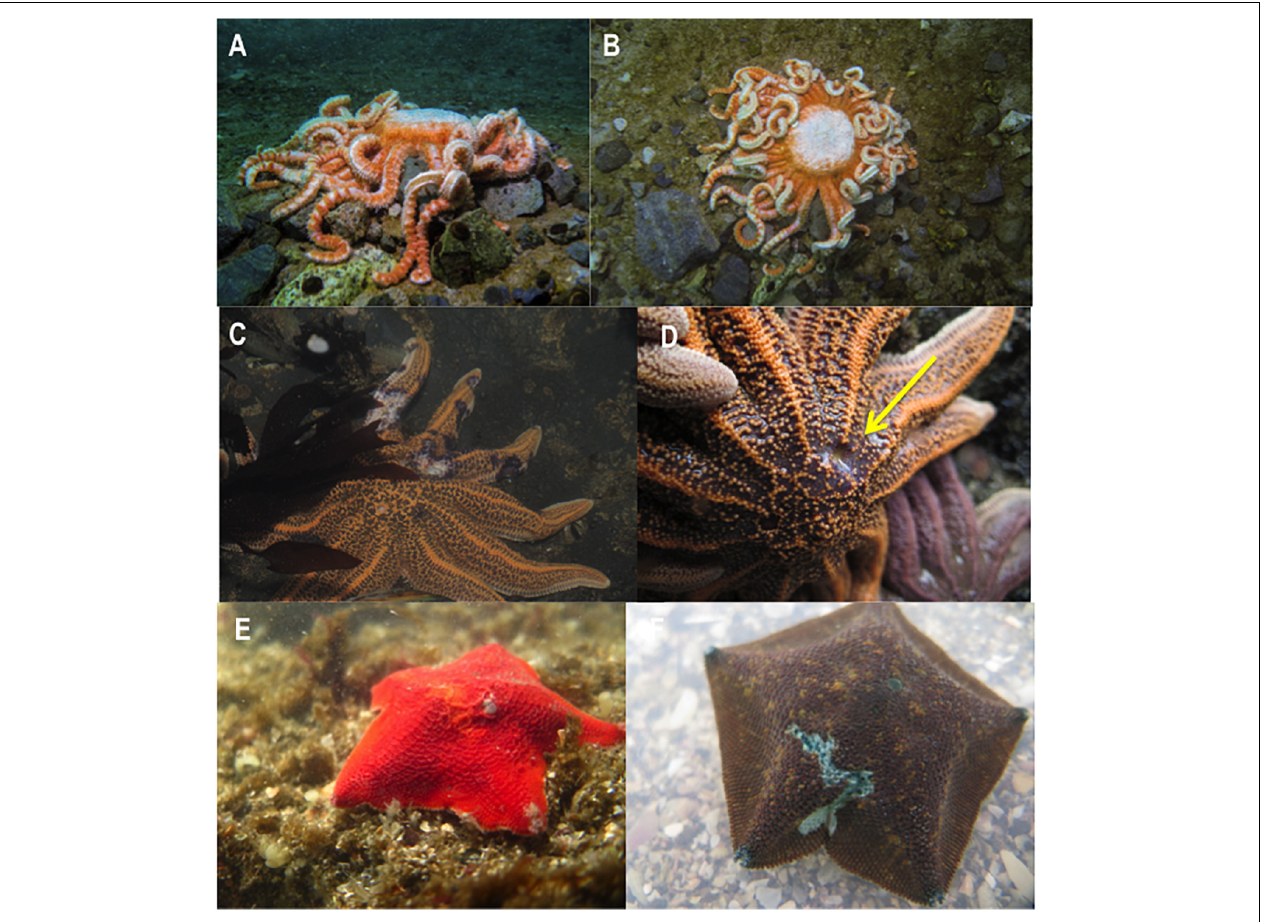
FIGURE 1 | Unidentified disorders in asteroids. (A,B) Labidiaster sp. From Antarctica showing wasting signs. The individual was the sole example demonstrating abnormalities amongst hundreds of individuals (Photo credit Shaylyn Potter). (C) Lesions on Stichaster australis from Muriwai, Auckland, New Zealand in June 2015. The individual was the sole example of affected stars amongst hundreds. Subsequent surveys in the area later in 2015 revealed no additional stars (Photo credit Richard Taylor). (D) Degraded madreporite in S. australis from Piha, Auckland, New Zealand (madreporite indicated by yellow arrow) (E,F) Lesions on Patiriella regularis from the North Island of New Zealand, in December 2017 and January 2018, respectively. The individuals were one of a small handful with lesions which may indicate physical